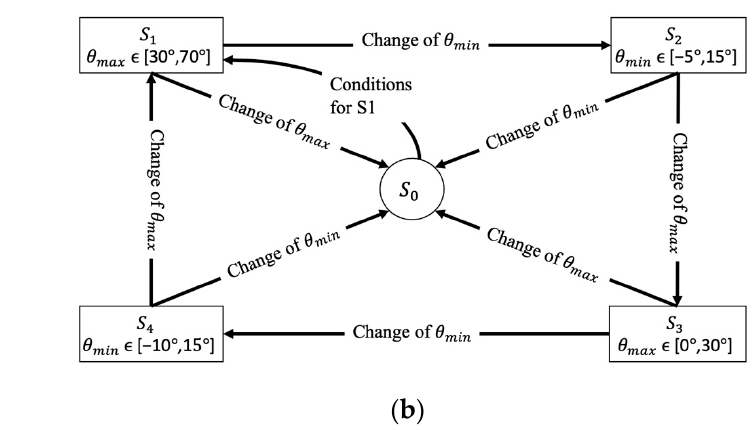
Figure 5. ( a ) States and maximum/minimum angles during the activity of walking; ( b ) sequence of states S 0 , S 1 , S 2 , S 3 , and S 4 with their respective condition for change, the detection of the walking activity occurs when a transition from S 4 to S 1 occurs.